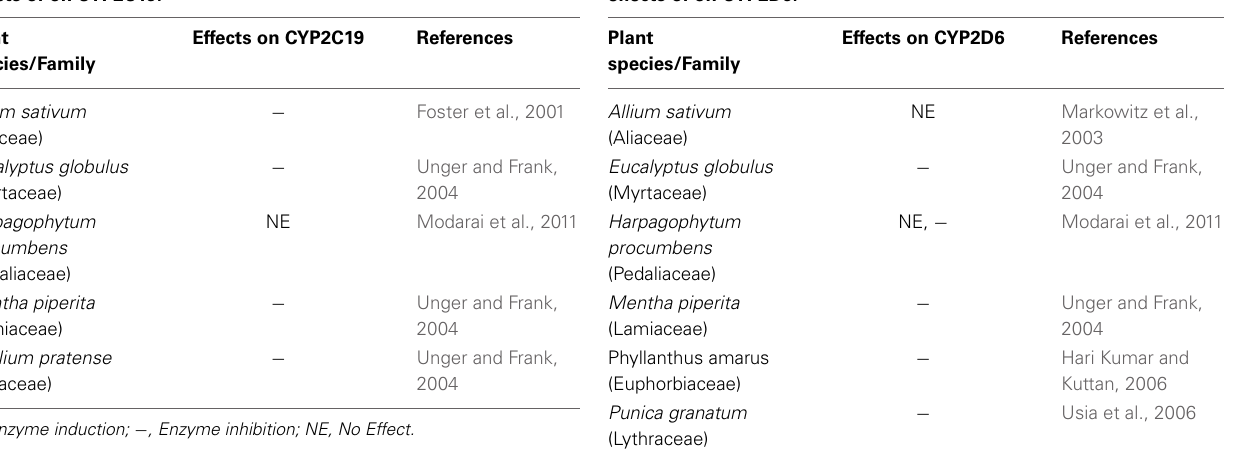
Table 4 | Medicinal plant species listed in RENISUS with reported effects of on CYP2D6.